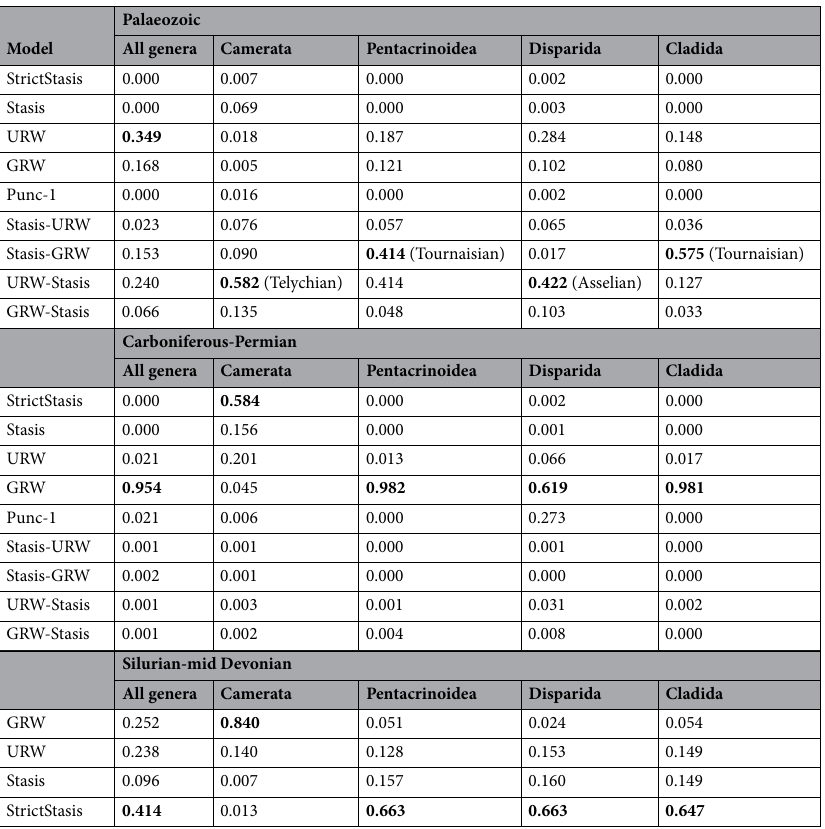
Table 1. Support (AICc weights) for models of calyx size evolution for crinoids as a whole and within major sister subclades for different intervals. Best supported models are indicated in bold. For shorter intervals only simple models were taken into account. Time (geological period) of the shift in the evolutionary dynamics in the complex models are indicated in